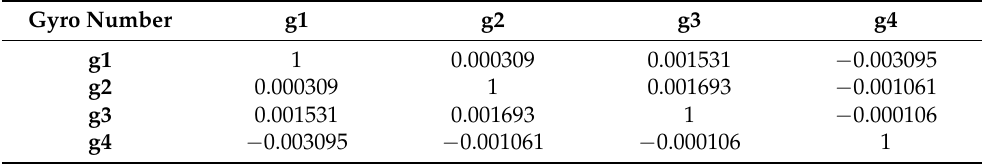
Table 8. Comparison results of the Allan variance measurement for